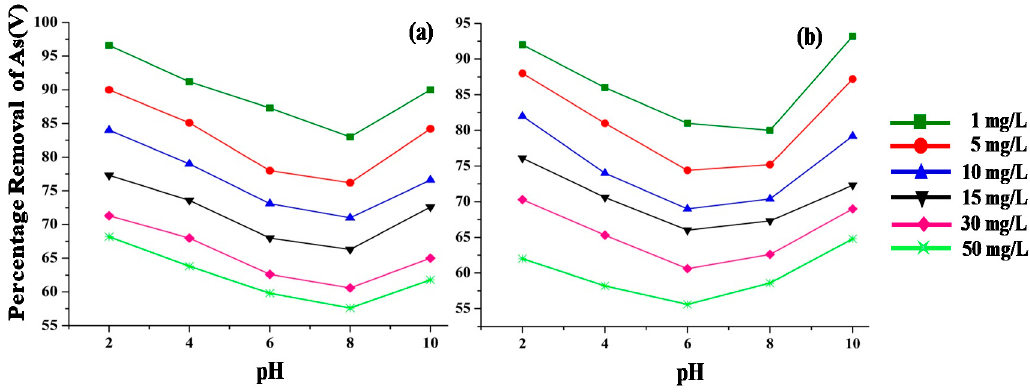
Figure 9. As(V) removal efficiency at different pH levels and arsenic concentration by ( a ) IONPs–C-0.15 and ( b ) IONPs–PA-0.15.